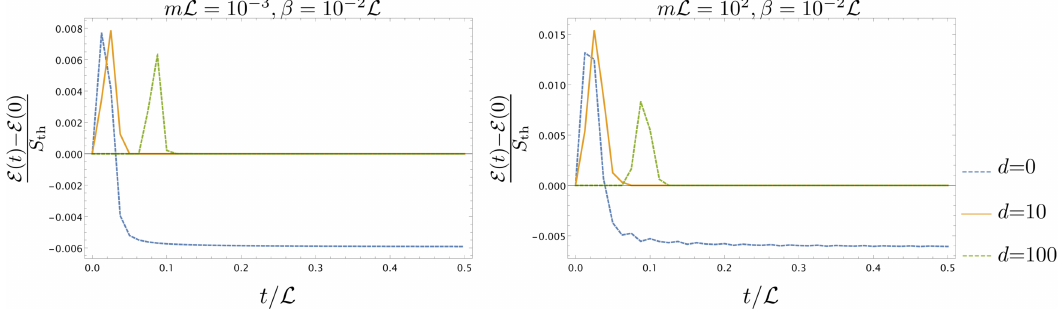
= N + A L 1( R 1) L ( R )